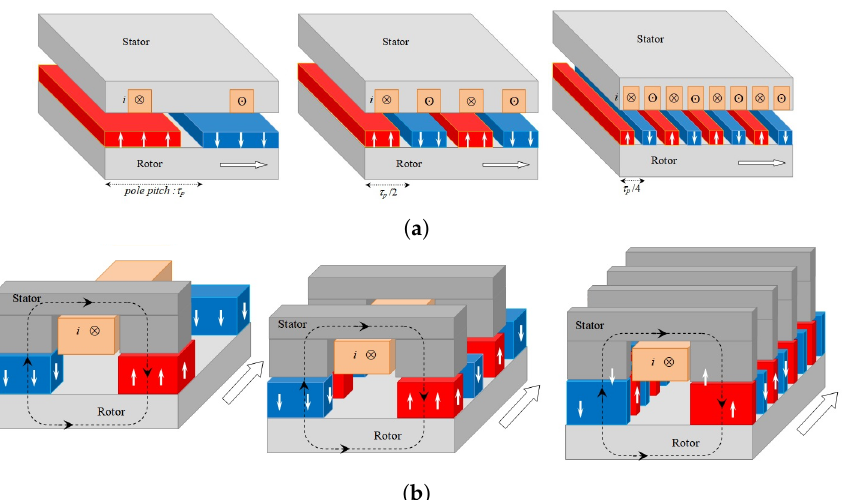
Figure 14. The influence of the pole pitch reduction on PMSG’s force density. ( a ) Longitudinal PMSG. ( b ) Transverse Flux PMSG.